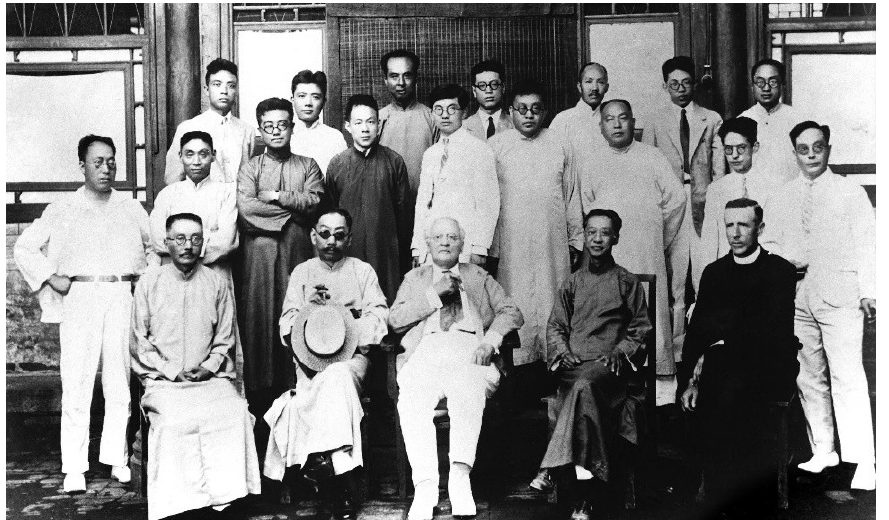
Figure 1. Founders of Chinese geology and paleontology gathering at Amadeus W. Grabau’s home in Beijing in 1935. Front row, from the left: Hongzhao Zhang, Wenjiang Ding, Amadeus W. Grabau, Wenhao Weng, and Pierre Teilhard de Chardin. Middle row, from the left: Zhongjian Yang, Zanheng Zhou, Jiarong Xie, Guangxi Xu, Yunzhu Sun, Xiechou Tan, Shaowen Wang, Zanxun Yin, and Fuli Yuan. Back row, from the left: Zuolin He, Hengshen Wang, Zhuquan Wang, Yuelun Wang, Huanwen Zhu, Rongseng Ji, and Jianchu Sun (credit to IVPP).